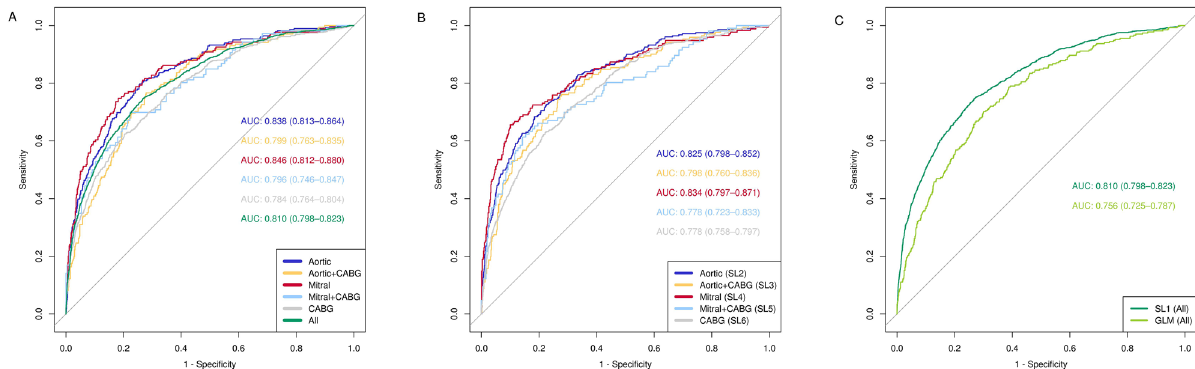
Figure 1. Plot of the receiver operating characteristic (ROC) curves and the respective areas under curve (AUCs) for the weighted Super Learner 1 for each of the 5 types of operation and for the whole cohort. Plot of the receiver operating characteristic (ROC) curves and the respective areas under curve (AUCs) for the weighted Super Learner and the generalized linear model (GLM) for the whole cohort. SL super learner, CABG coronary artery bypass